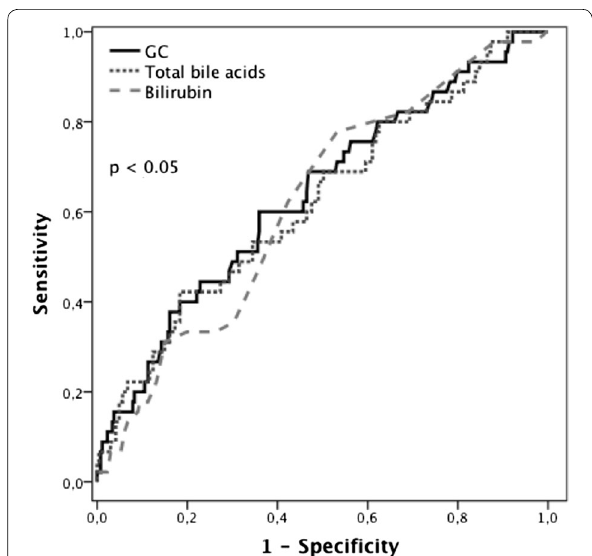
Fig. 2 Total and individual serum bile acids predicting 28-day mortality. ROC analysis for prediction of 28-day mortality of TBA (total bile acids), GC (glycocholic acid) and serum bilirubin on admission.